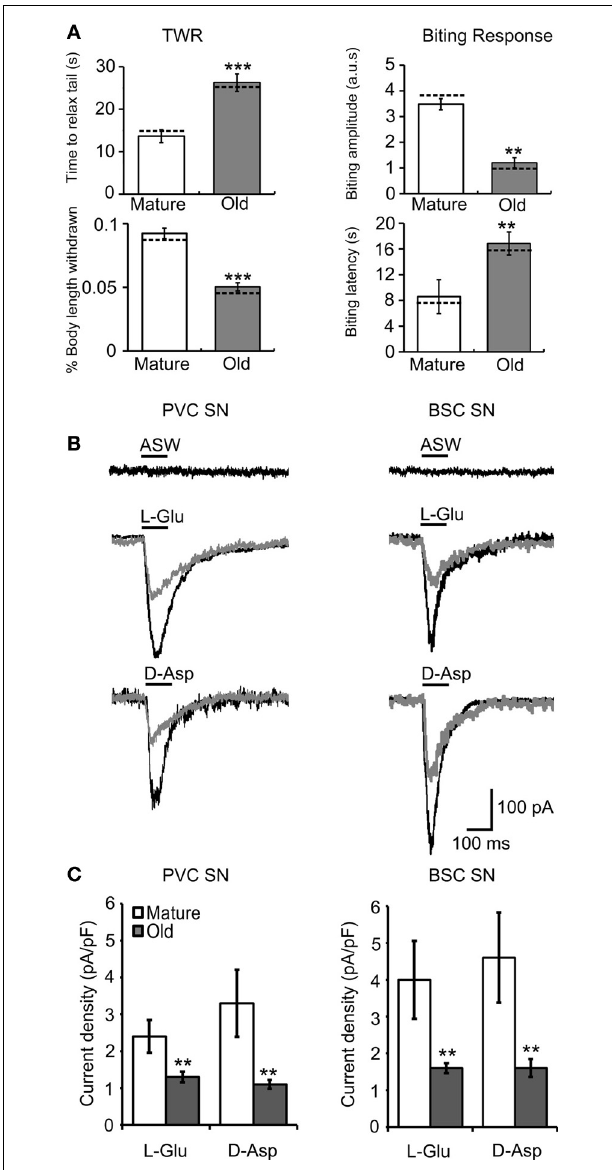
FIGURE 4 | Behavioral declines during aging correspond to altered agonist-induced responses in cultured PVC and BSC sensory neurons. (A) Behavioral measures in animals from cohort 2 sacrificed for electrophysiological experiments. The time to relax tail following tail touch increased and fraction of body length withdrawn decreased significantly with age ( p ≤ 0 . 001 in each case, 2-sample t -tests). The biting latency increased and biting amplitude decreased significantly with age ( p ≤ 0 . 01 in each case; n = 14 for M, n = 12 for O). Dotted horizontal lines are individual behavioral measurements in animals whose electrophysiological responses are illustrated in (B) . (B) Representative whole cell currents evoked in response to a 100ms pulse of 1mM L-Glu in mature and old PVC and BSC neurons. No current was evoked in response to a 100ms pulse of ASW alone. (C) Excitatory currents evoked by L-Glu and D-Asp decreased significantly with age in PVC ( n = 14 for M, n = 23 for O) and BSC neurons ( n = 22 for M, n = 15 for O; p ≤ 0 . 01 in each case, 2-sample t -tests). ∗∗ and ∗∗∗ denote significant difference from mature at p ≤ 0 . 01 and p ≤ 0 . 001,